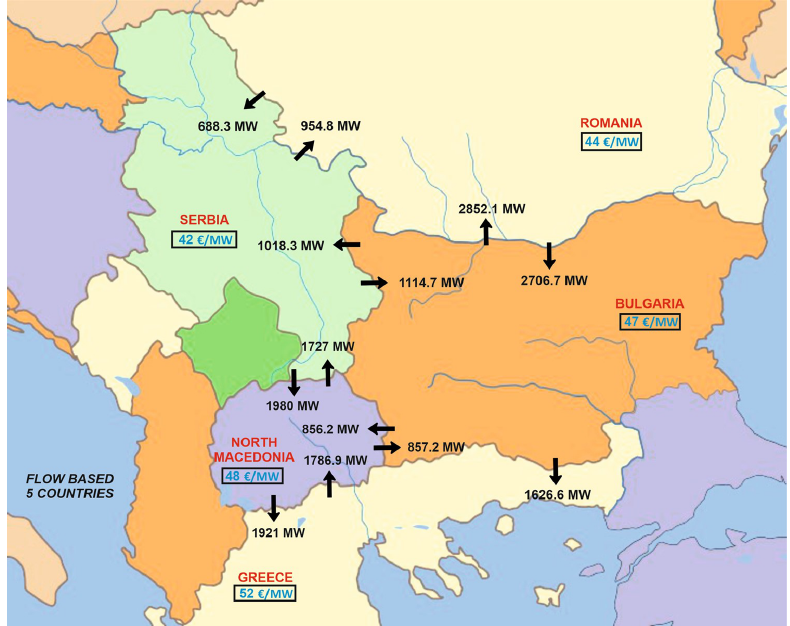
Figure 3. Cross-border trading with the flow-based method for the five